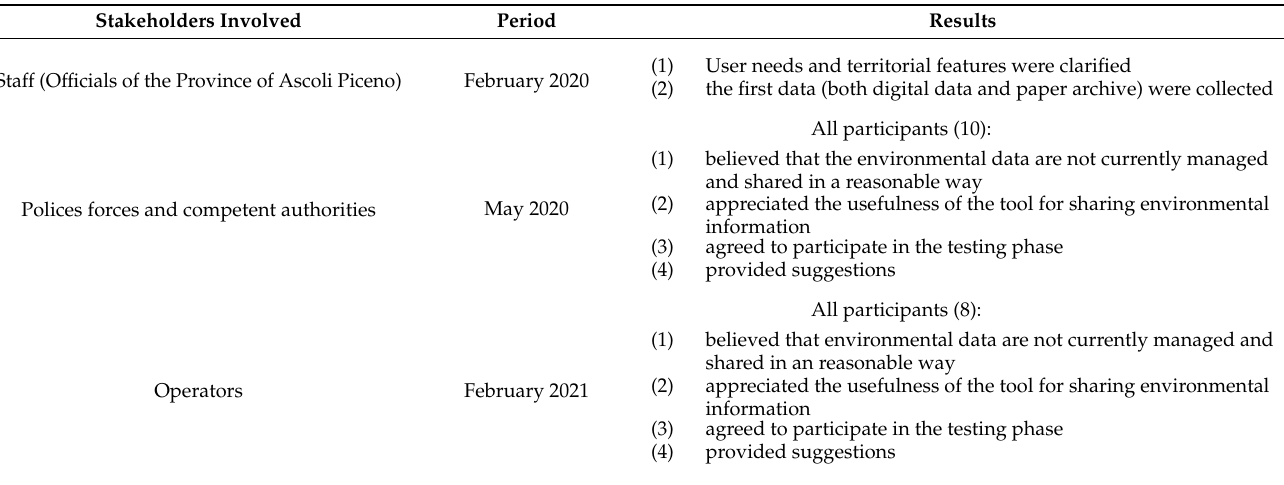
Table 1. Results of the preliminary